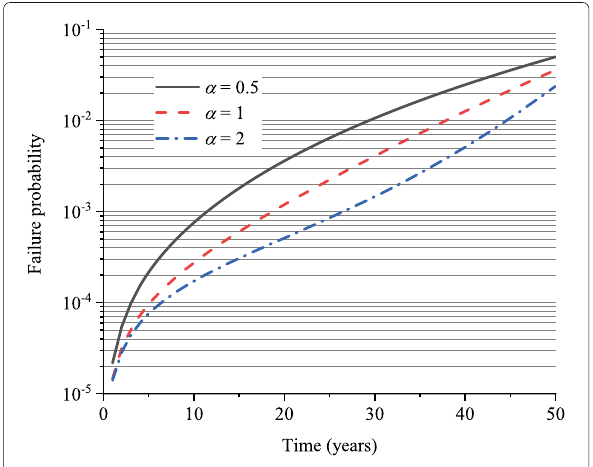
Fig. 9 As of Fig. 8 but with g ( 50 ) = 0.7